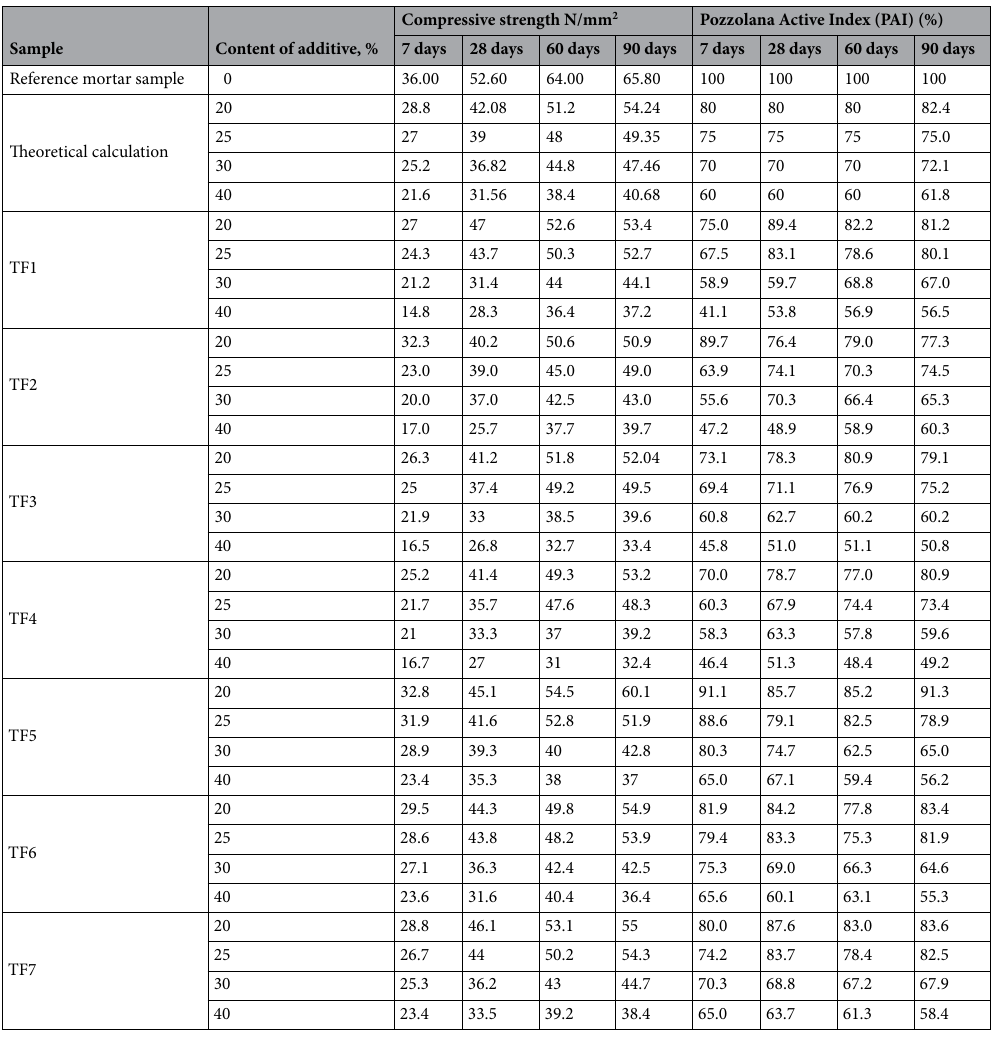
Table 6. Pozzolanic reaction degrees and micro-filler effects of tuff samples in the tuffs/ mortar.